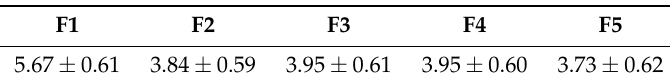
Table 3. Thickness of soft tissue at the fingertip in mm (mean ± standard deviation) according to Buryanov et al.